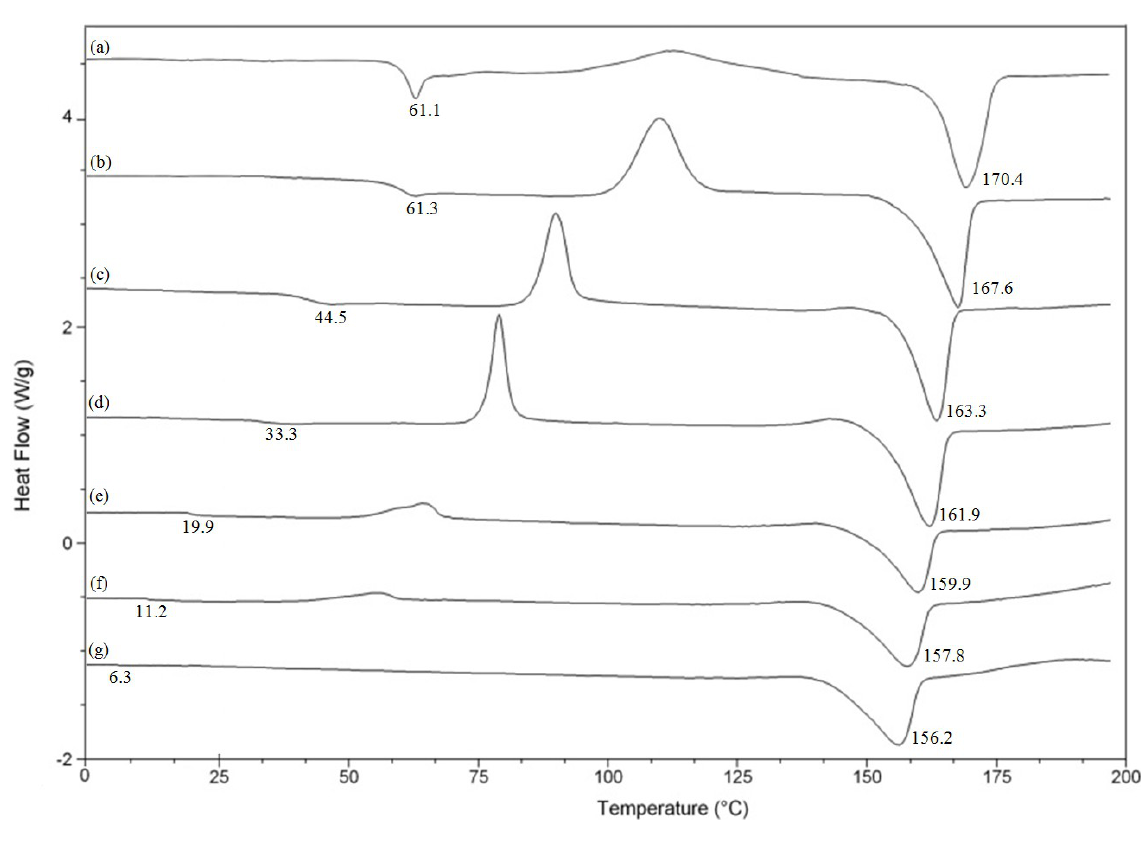
tapioca MDI; ( c ) (PLA 70 30 MDI) ATBC ; ( e ) (PLA 30 90 10 ATBC ; and ( g ) (PLA tapioca a b 70